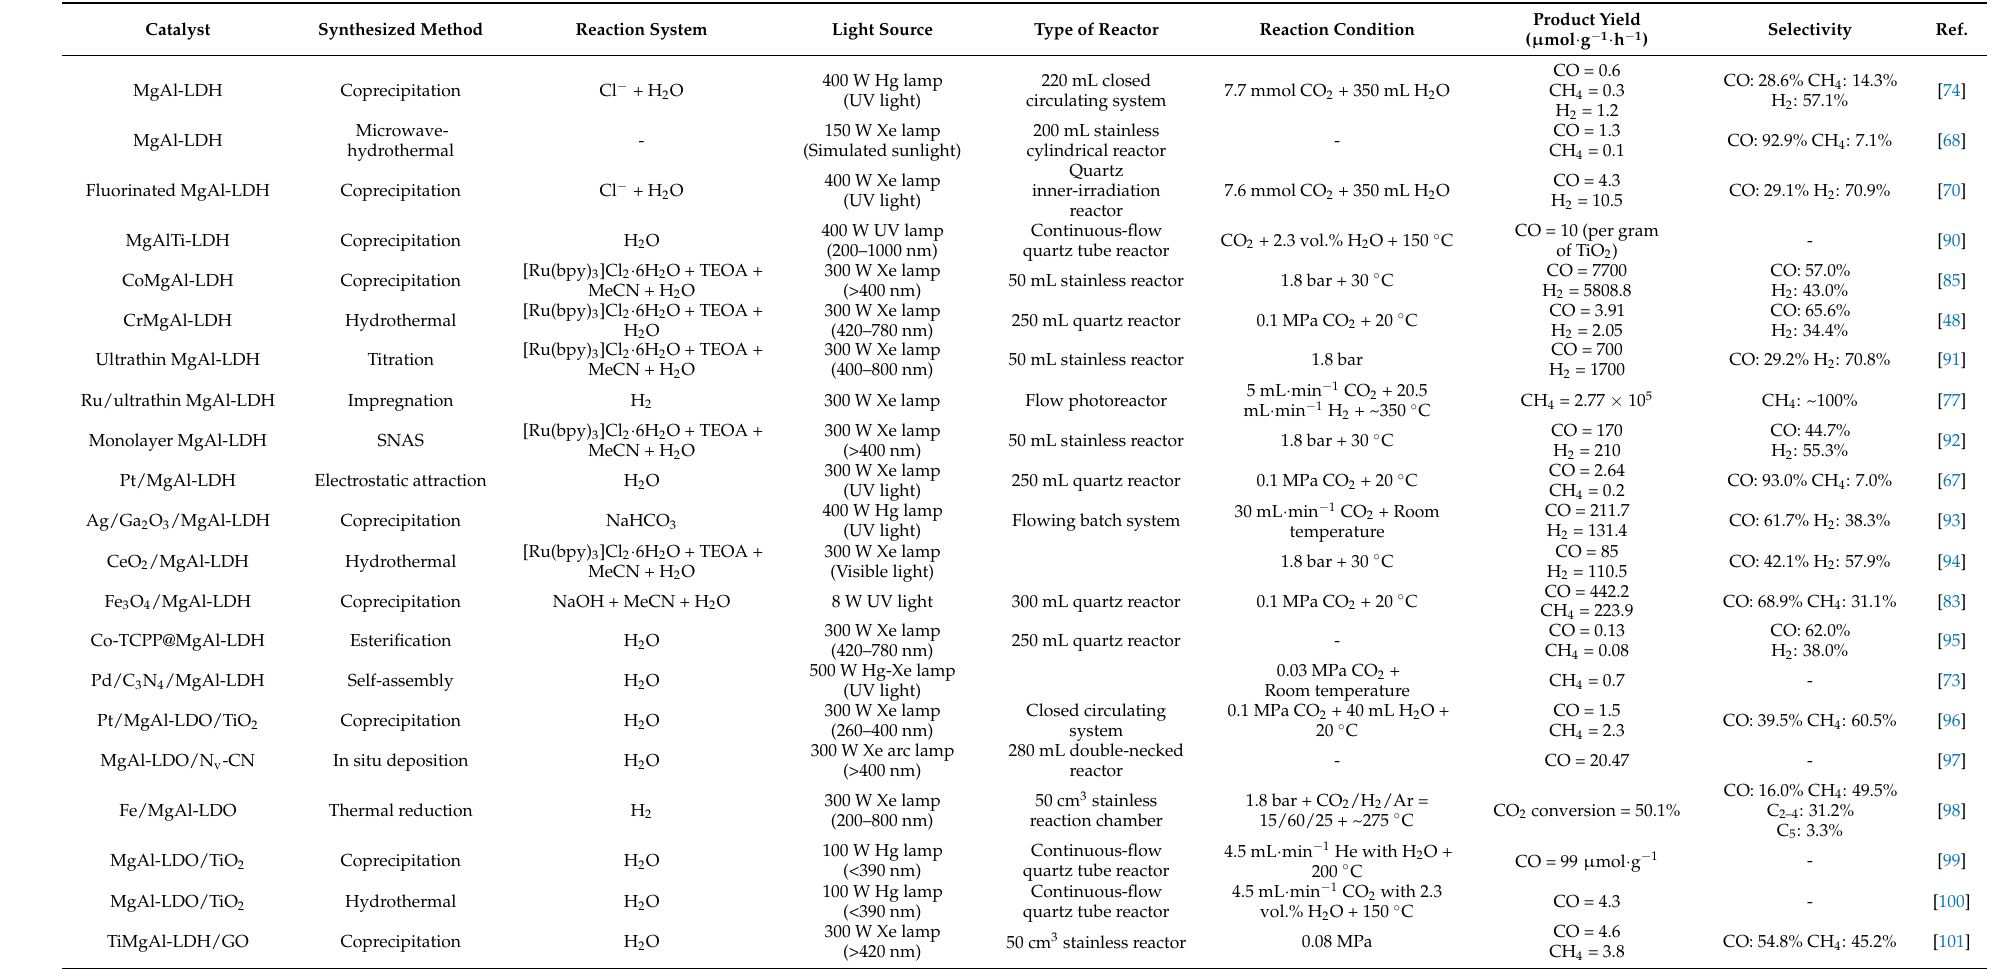
Table 3. Summary of MgAl-LDH based photocatalysts for CO 2